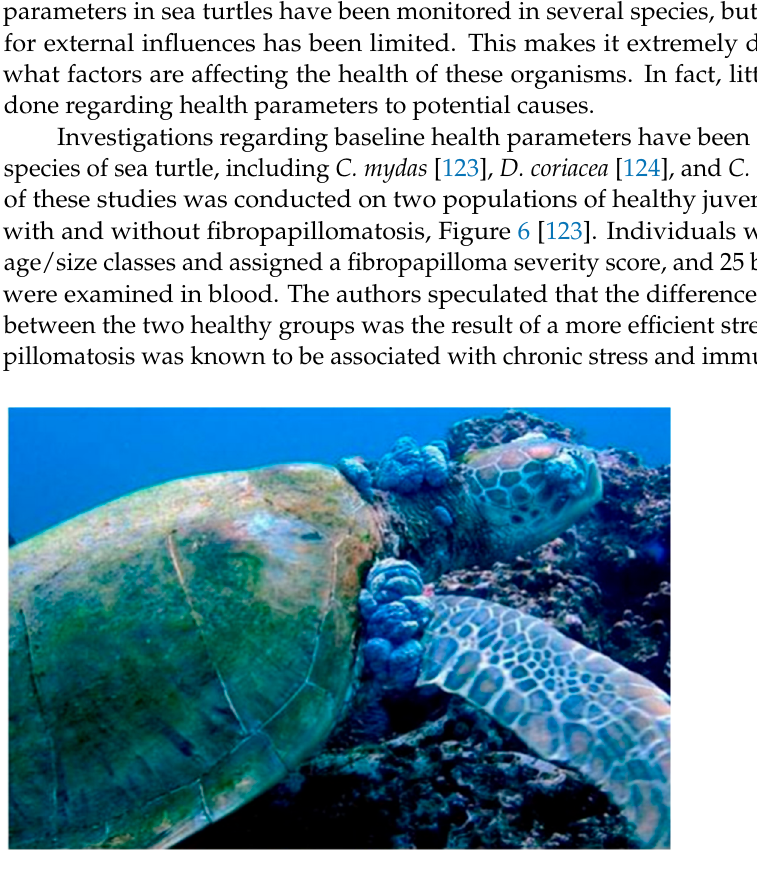
Figure 6. Fibropapillomatosis around the neck in green sea turtles from Hawaii [123].